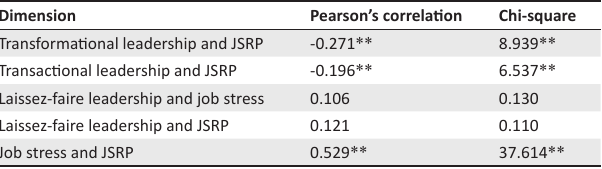
TABLE 5: Pearson’s correlation and associated chi-square values between leadership styles and job stress and job-stress-related presenteeism. Dimension Pearson’s correlation